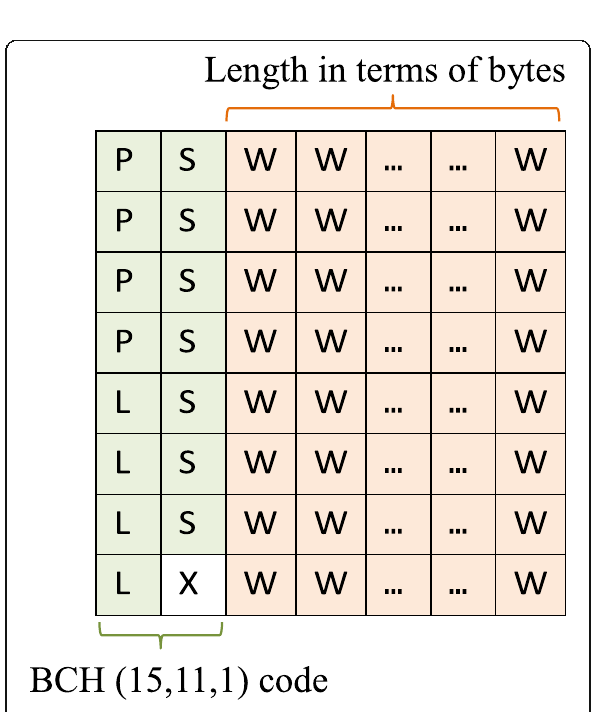
Fig. 3 Bit arrangement in each package. The BCH code contains 7 “ S ” bits for the location index, 4 “ L ” bits for the package length, and 4 “ P ” bits for the parity symbol. The remaining “ Ws ” represent watermark